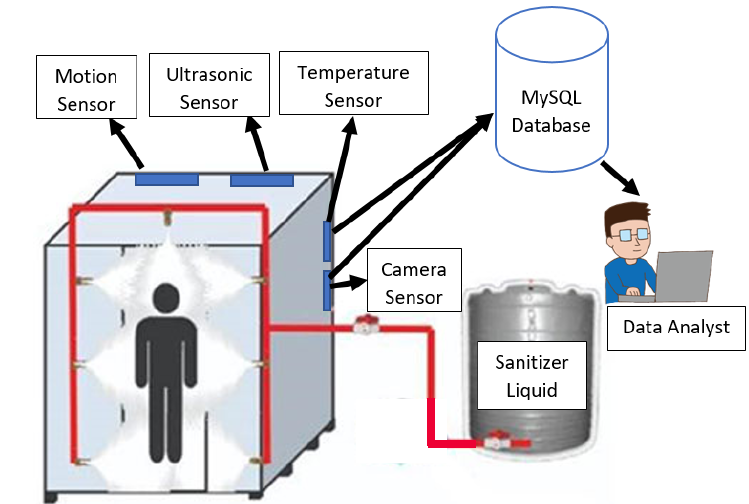
Figure 6. Smart Screening and Disinfection Walkthrough Gate (SSDWG).